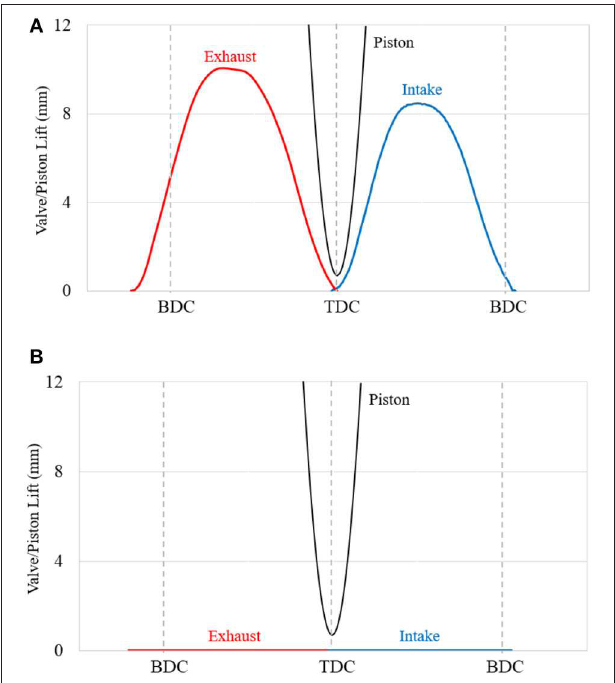
FIGURE 4 | (A) Valve profiles for normal operation and Cylinder Cutout operation. (B) Valve profiles for the deactivated cylinders for CDA operation.